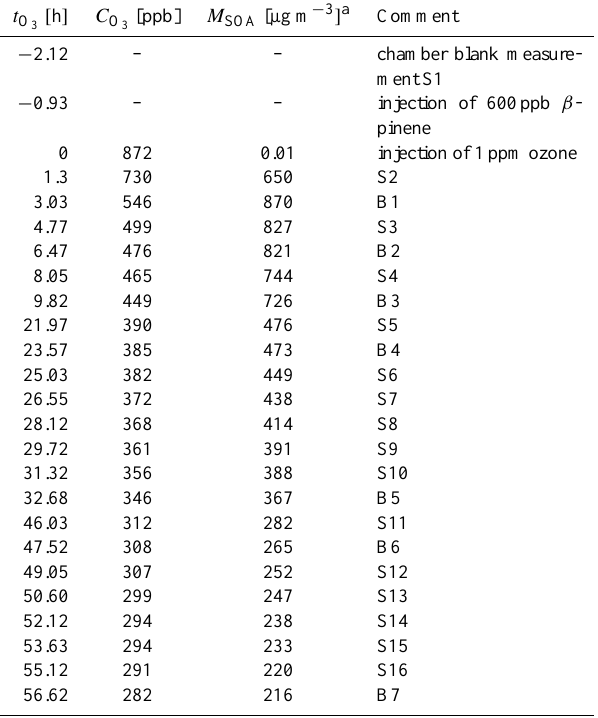
Table 1. Overview of the course of the β -pinene experiment and the samples collected with the ACM GC-MS and filter measurements. t O is the time after ozone was injected into the chamber. C O 3 mixing ratio of ozone in the chamber. M SOA is the total SOA mass inside the chamber. S indicates that a chamber sample is collected with the ACM GC-MS and in parallel with quartz filters and B in- dicates that a ACM GC-MS blank measurement was